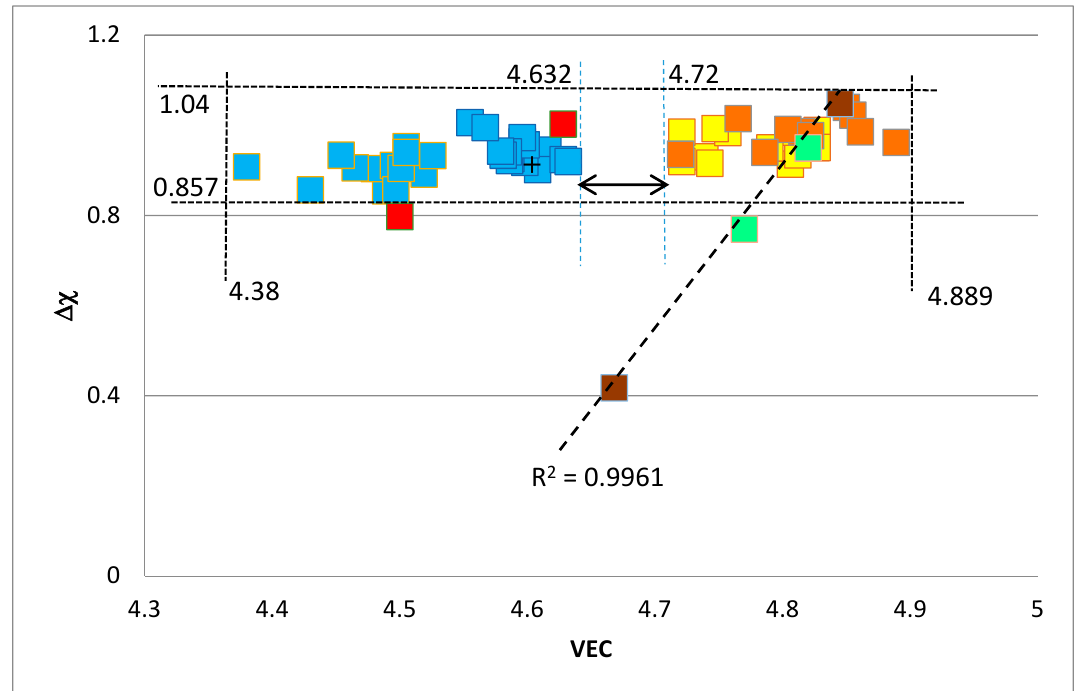
Figure 6. Map of ∆χ versus VEC of A15–Nb 3 X phases where Nb is substituted by Cr, Fe, Hf, Mo, Ti, W and X = Al, Ge, Si, Sn. Brown, red and green squares represent data for Nb 3 X with X = Sn, Al or Ge, respectively. Light brown squares represent data for Nb substituted by Cr, Hf, Mo, Ti, W and X = Al, Ge, Si, Sn, yellow squares represent data for Nb substituted by Cr, Hf, and X = Al, Si, Sn and blue squares represent data for Nb substituted by Cr, Fe, Hf, Ti and X = Al, Si, Sn.